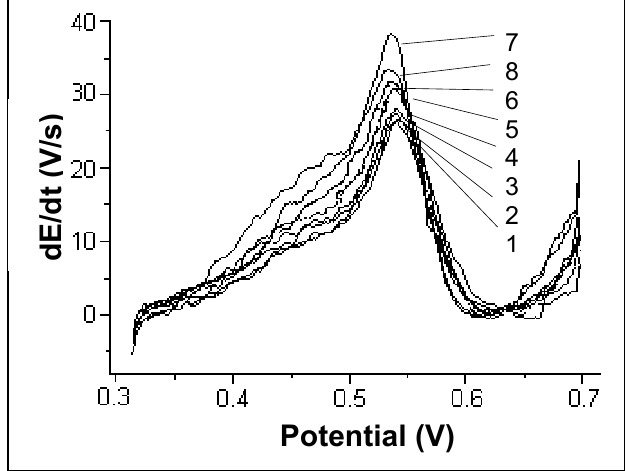
Figure 7. Chronopotentiograms registered for a mercury concentration of 20 μ g/L to which different amounts of Cu(II) were added. The ratios C 5 (4); 10 (5); 20 (6); 25 (7); 50 (8). Experimental conditions were as described at the working